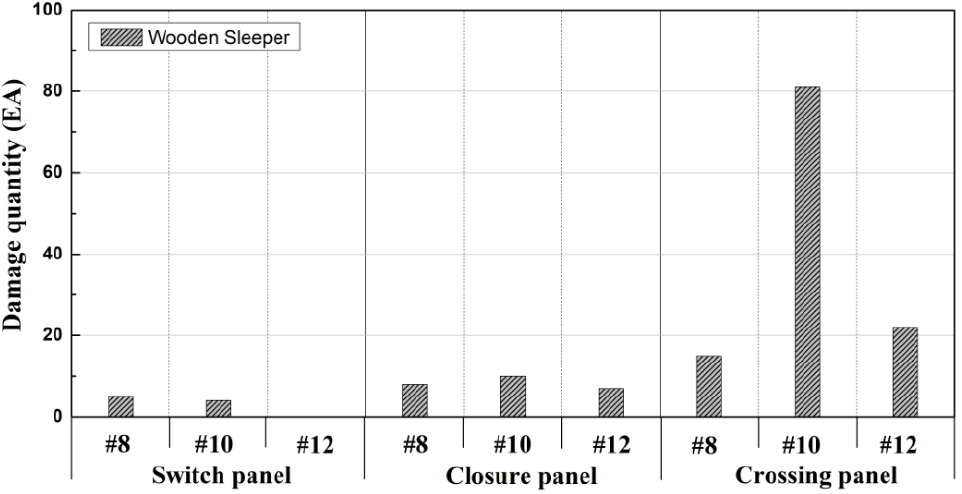
Figure 13. Damage status of wooden sleepers.